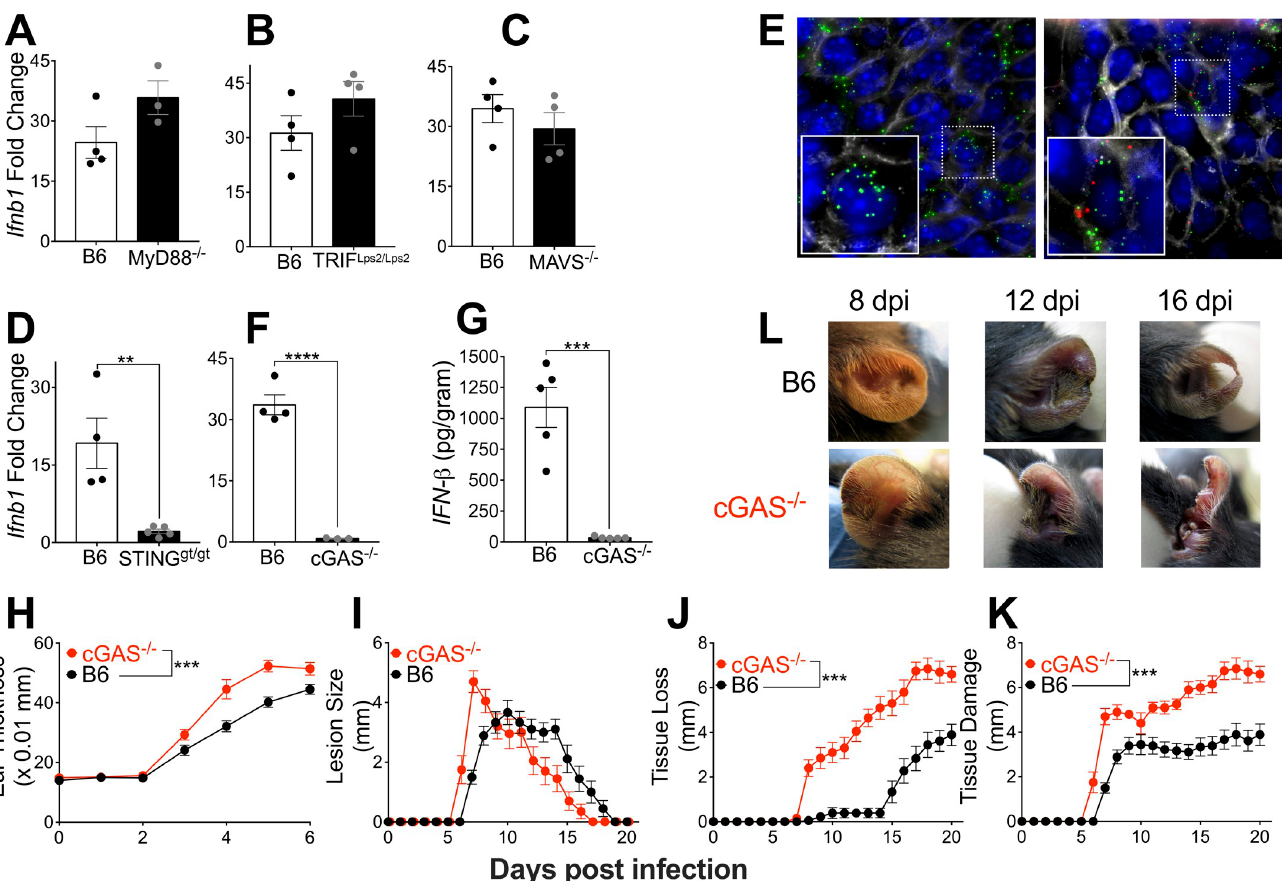
Fig 3. cGAS sensing of VACV-infected cells induces T1-IFN to limit local tissue pathology. (A-D) Expression of IFN- β in ear tissue of mice 5 dpi measured by RT-qPCR. (E) Cryosections of ear tissue from wild-type mice 5 dpi with VACV-OVA stained with Wheat-Germ Agglutinin (Grey) to visualize cell membranes and DAPI (Blue) for nuclei. RNA fluorescence in situ hybridization was used to detect viral RNA (OVA-Green) and cellular IFN- β (Red). (F,G) Expression of IFN- β in ear tissue of mice 5 dpi measured by RT-qPCR (F) or ELISA (G). (H-K) Tissue pathology of the ear pinnae after intradermal infection with VACV; ear thickness (H), lesion size (I), tissue loss (J), or total tissue damage (K), n = 9–10 mice per group. (L) Representative pictures of ear pinnae following intradermal VACV